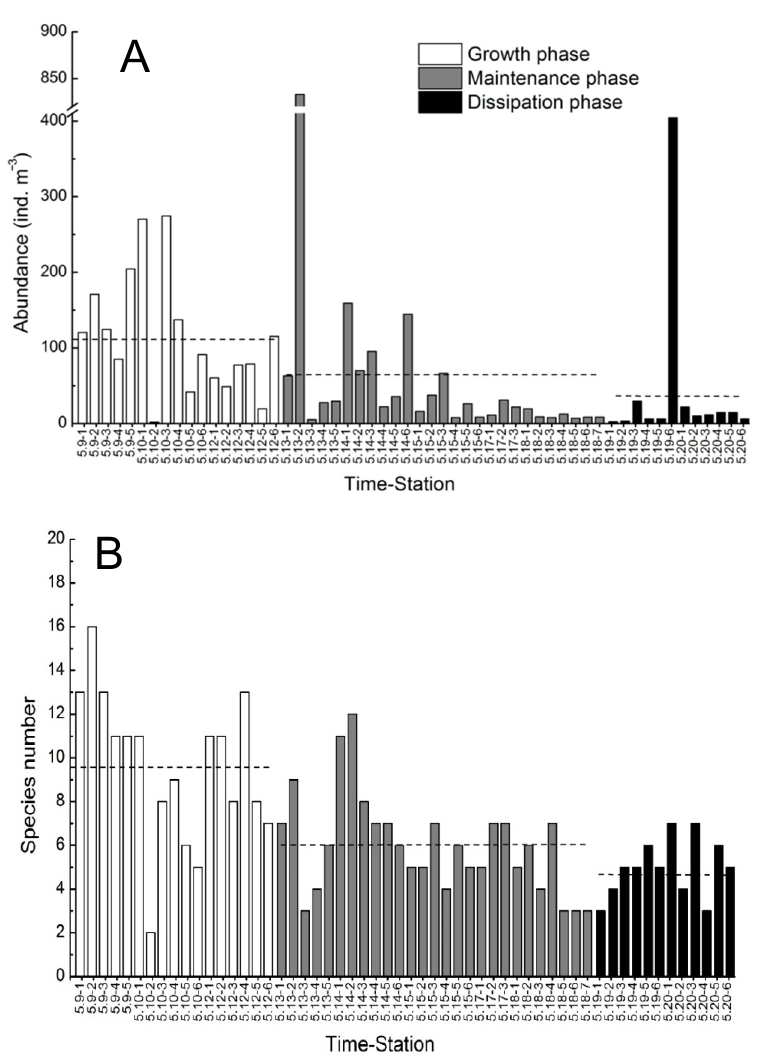
Figure 4. The abundance of zooplankton ( A ) and diversity changes ( B ) at each sampling station in the different phases of the P. donghaiense bloom (the dash represents average